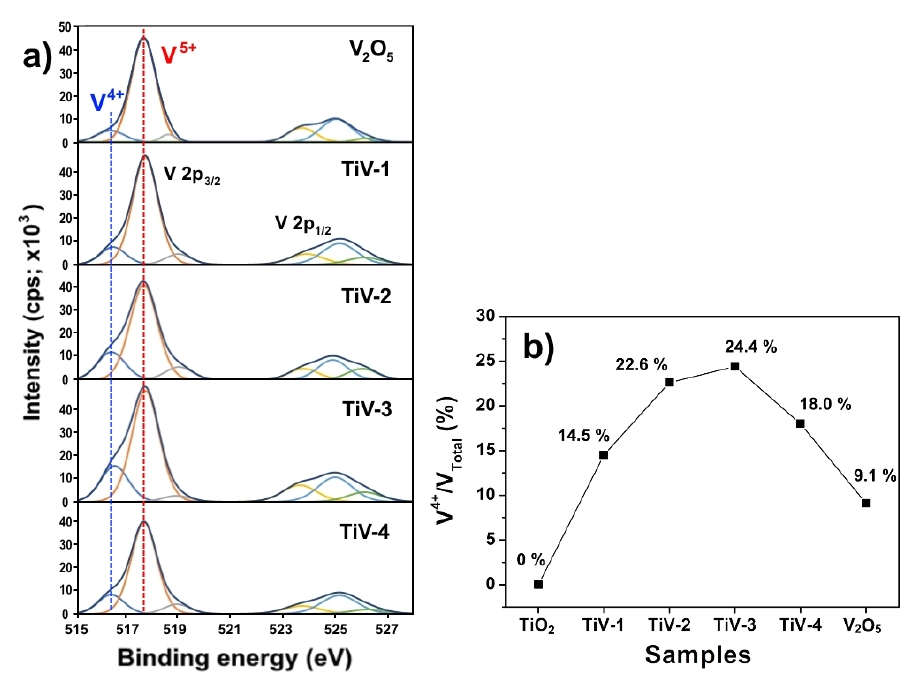
Figure 4. ( a ) A comparison of the high-resolution V 2p XPS spectra for all prepared samples and ( b ) V 4 +/ V total ratios of pure TiO 2 , TiV1-4 heterostructure, and V 2 O 5 samples. Molecules 2020 , 25 , x FOR PEER REVIEW